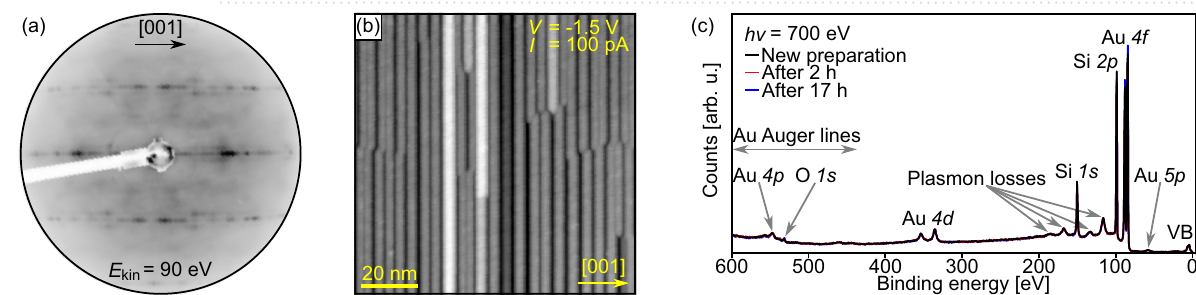
Figure 1. ( a ) LEED image, ( b ) STM image, and ( c ) Si 2p spectrum of clean Si(110) substrates.